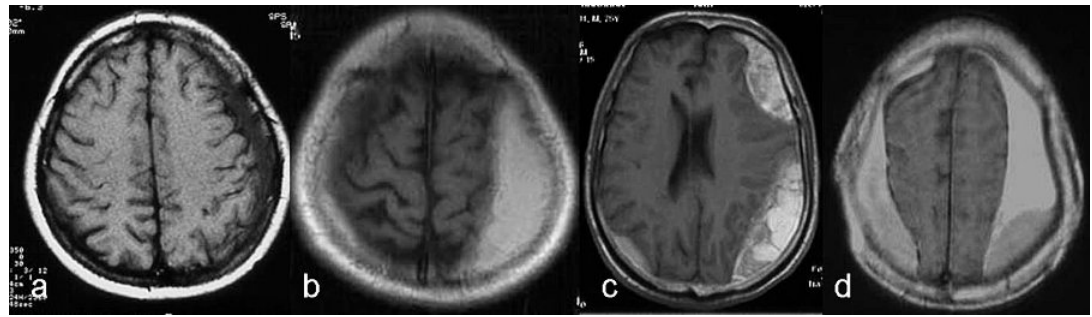
intensity haematomas with levelling.